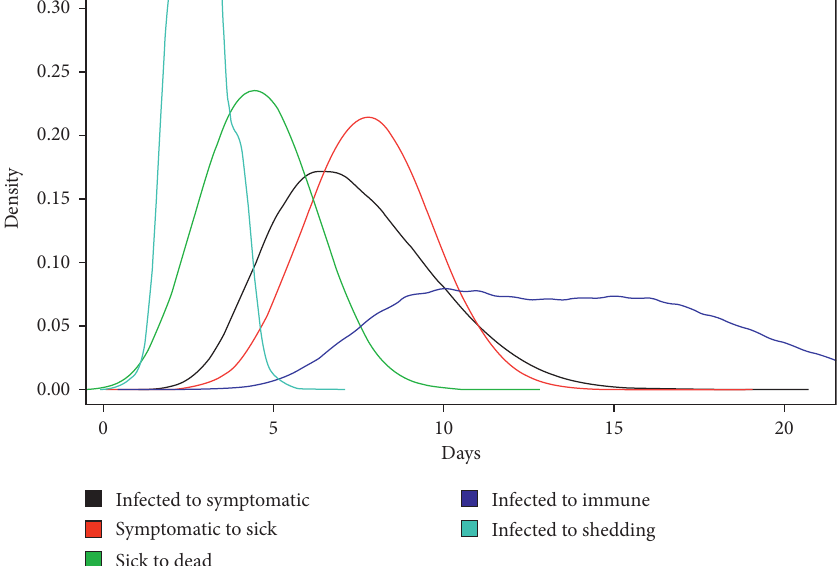
Figure 2: Observed densities of time between events in the model.